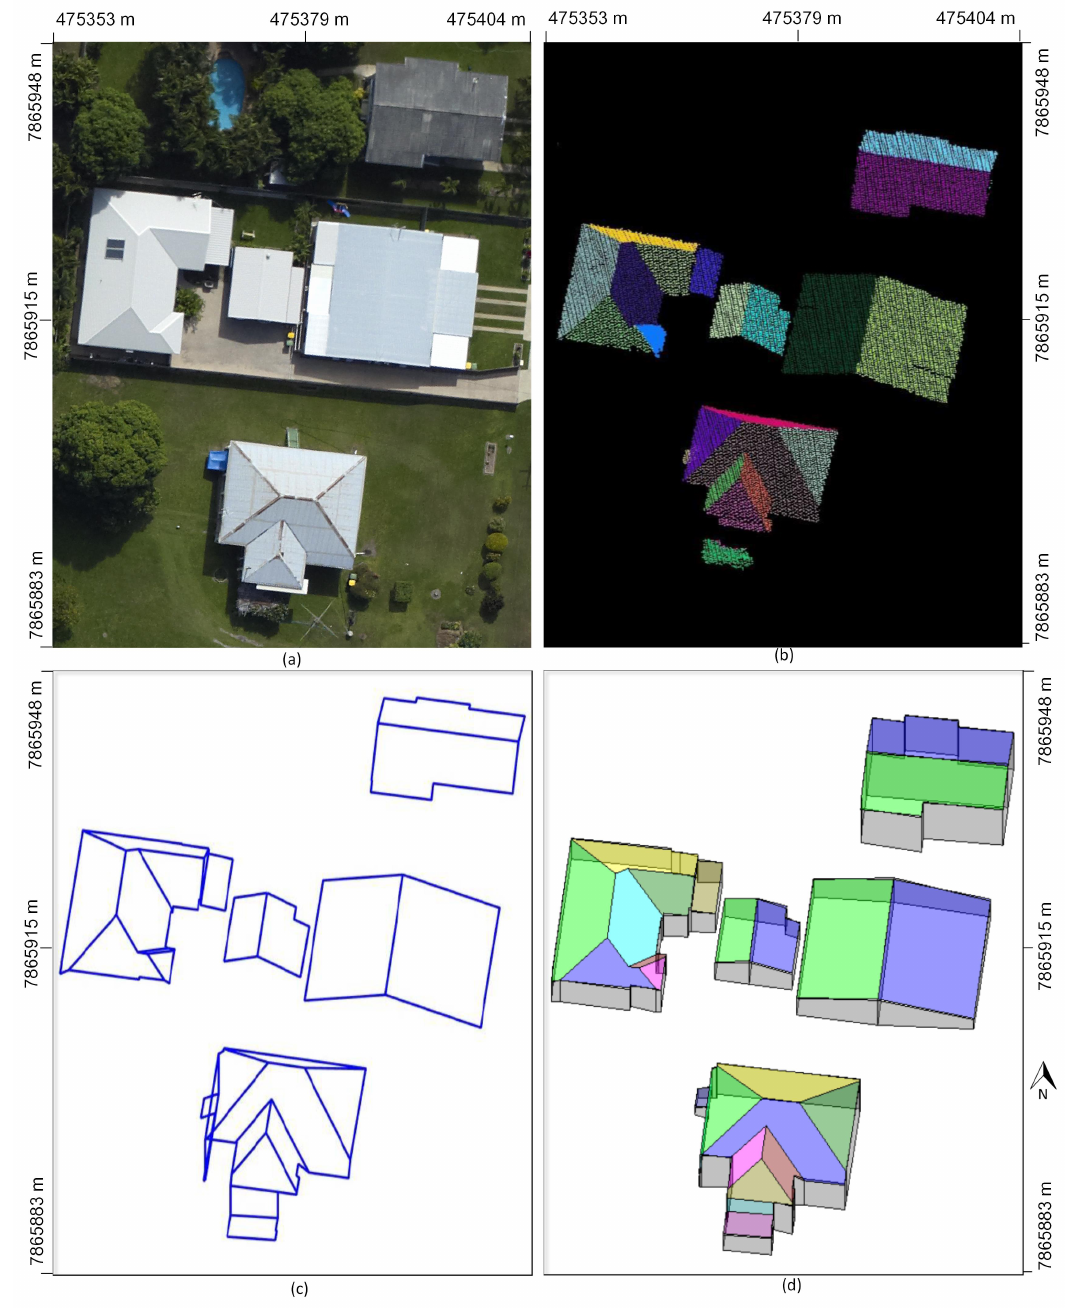
Figure 15. 3-D reconstructed models from Aitkenvale dataset: ( a ) aerial image; ( b ) LiDAR points of input roof planes; ( c ) building roof models; and ( d ) 3-D building